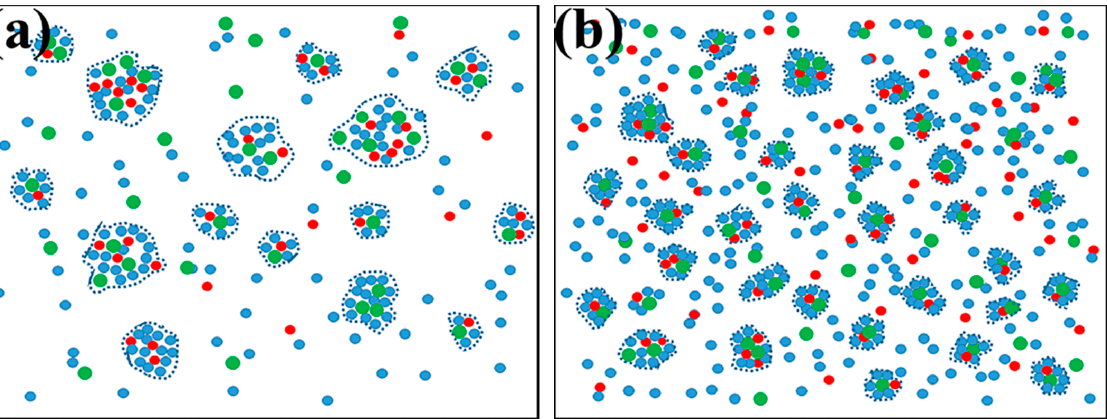
Figure 11. Schematic diagram of Al 3 (Sc, Zr) nucleation: ( a ) Without ESMT; ( b ) With ESMT; Al atom group, Sc atom group, Zr atom group.